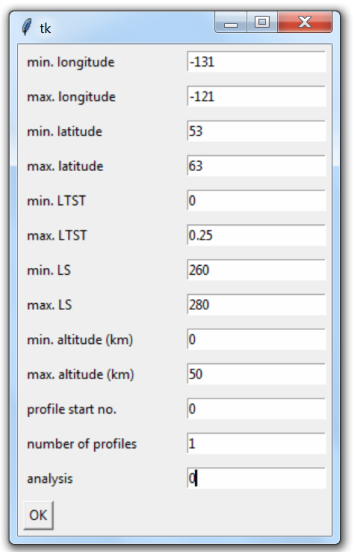
Figure 2. Screen capture of the framework’s GUI form that fea- tures the input fields used for searching the data. The last input field is for choosing an analysis option. The user enters the minimum and maximum bounds of the search parameters into the input fields. Longitude and latitude are the coordinates of the temperature profile of interest. Local True Solar Time (LTST) is the time of the temper- ature profile. LS is the areocentric longitude in degrees when the profile. Altitude is the altitude of the lowest point available in the profile, i.e. the lowest point of the profile needs to be in the min. or max. range entered in the altitude fields. The “profile start no.” input field indicates at what point in the search results to begin any output. The “number of profiles” indicates the number of profiles in the search results that should be output. The “analysis” input field options are described in the main